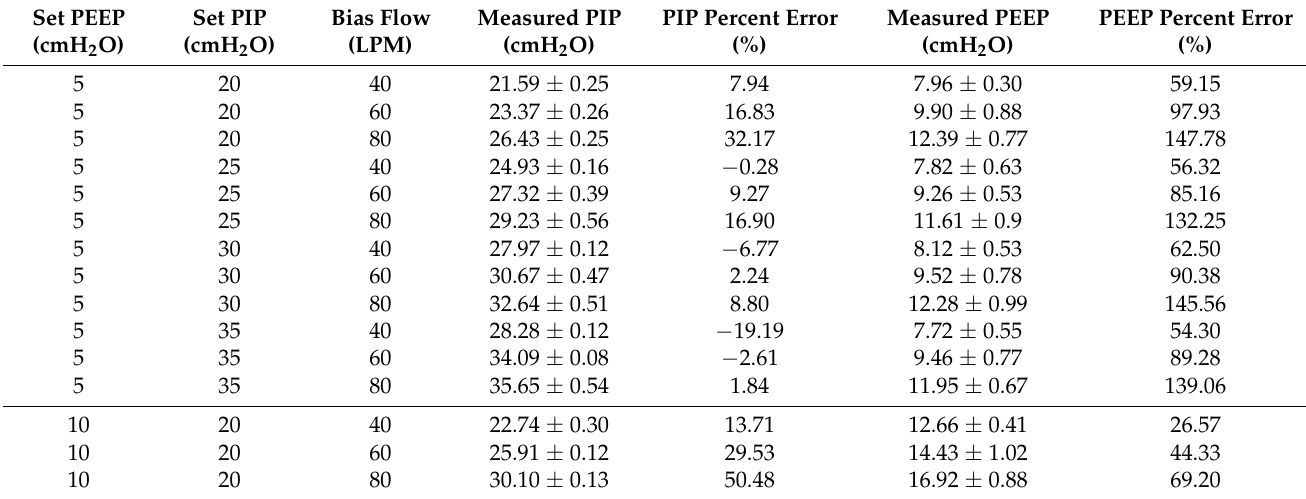
Table 4. Outcomes of Test 2. Measured PIP and PEEP when settings are PIP, PEEP, and bias flow settings are changed. Measured PIP and PEEP are given in mean ± SD and percent error is given as the deviation from the set